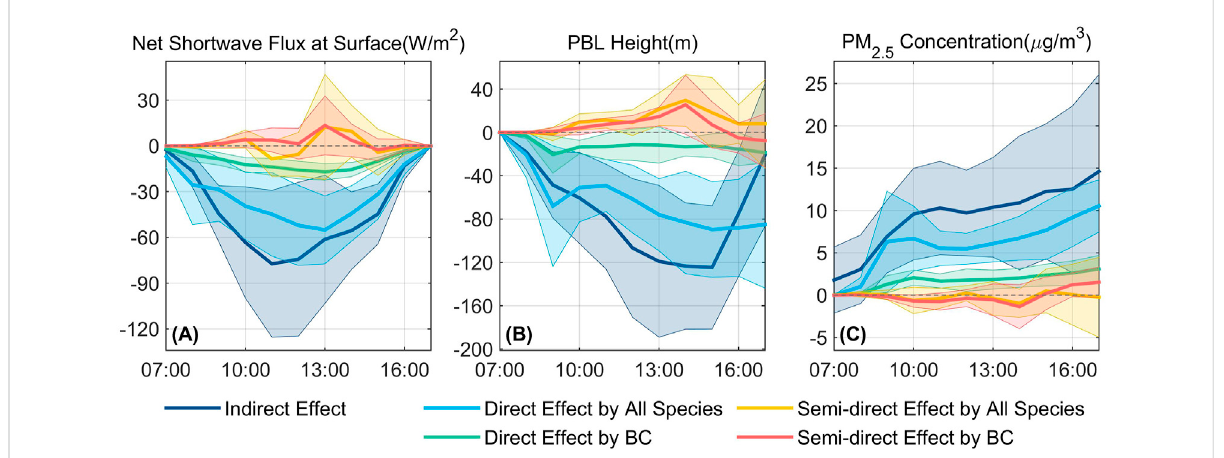
FIGURE 5 Time series of ensemble mean aerosol effect on (A) net shortwave fl ux at surface, (B) PBL height and (C) PM2.5 concentration in the Shanghai case,averagedovertheboxregionmarkedinFigure3D.Shadedareasrepresentensemblestandarddeviations.Notethatindirecteffectisscaledbya factor of 0.5 in this fi